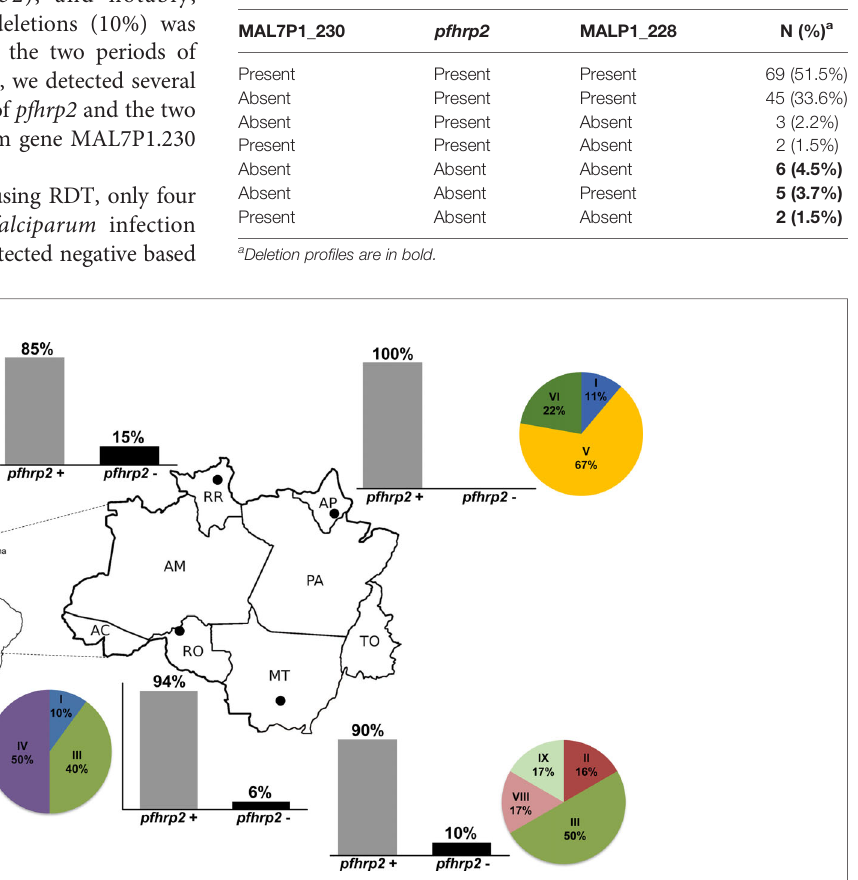
FIGURE 1 | The deletion pro fi les and variability patterns of pfhrp2 sequences of Plasmodium falciparum isolates from regions in the Brazilian Amazon. Bar plots show the proportion of pfhrp2 deletion in each of the surveyed states, and the pie charts show the frequency distributions for the patterns of pfhrp2 sequences. The localities of sample collection are shown on the map: Macapa ́ , Amapa ́ state (AP); Cuiaba ́ , Mato Grosso state (MT); Porto Velho, Rondo ̂ nia state (RO); Boa Vista, Roraima state (RR).